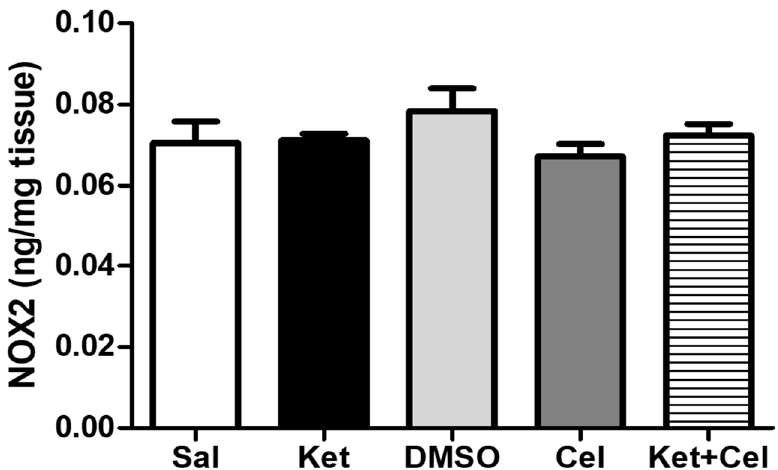
Figure 6. NOX2 levels were not altered in the cerebellum of adult mice exposed to ketamine in postnatal life. NOX2 levels (ng/mg tissue) in the cerebellum of adult mice receiving saline (Sal, n = 3) or ketamine (Ket, n = 5) or a 50% DMSO in PBS (DMSO, n = 3) or celastrol (Cel, n = 3) or ketamine + celastrol (Ket + Cel, n = 5) at PNDs 7, 9 and 11. One Way ANOVA, followed by Tukey’s post hoc test F = 1.158 p > 0.05 for all comparisons.